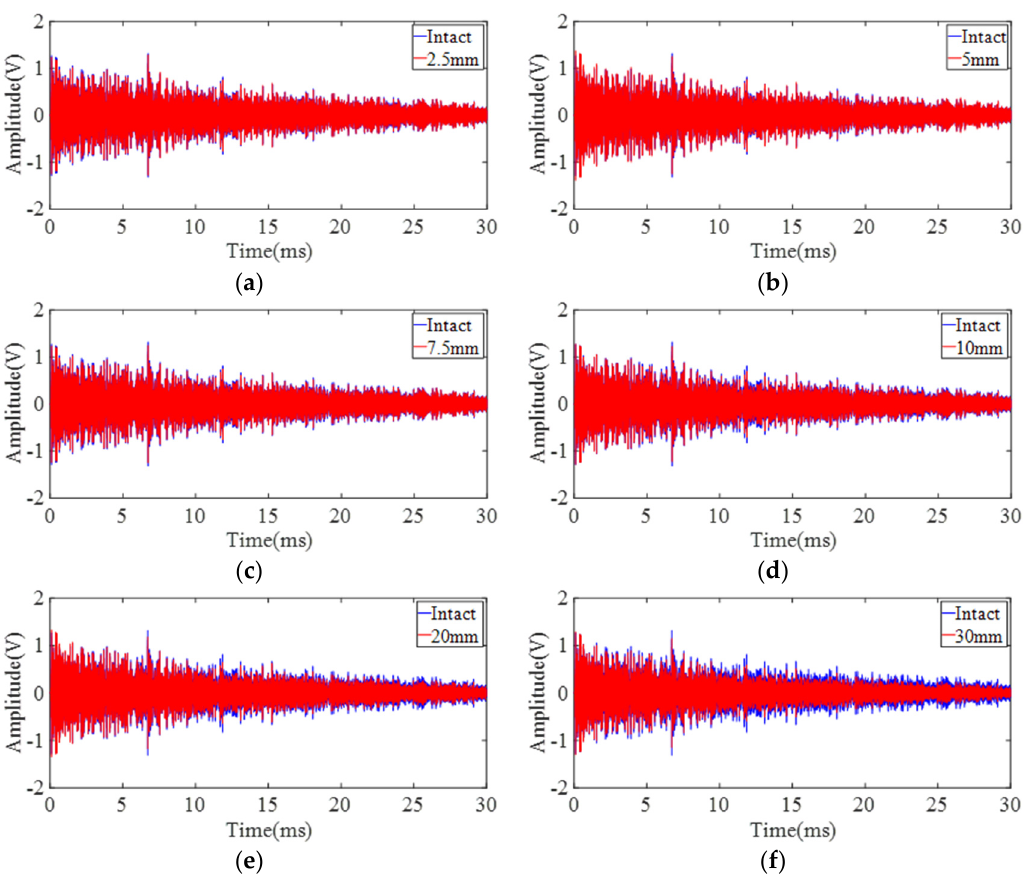
Figure 11. Signals obtained from six configurations on the middle point of the direct sensing path (site 1): ( a ) 2.5 mm defect; ( b ) 5 mm defect; ( c ) 7.5 mm defect; ( d ) 10 mm defect; ( e ) 20 mm defect; ( f ) 30 mm defect.